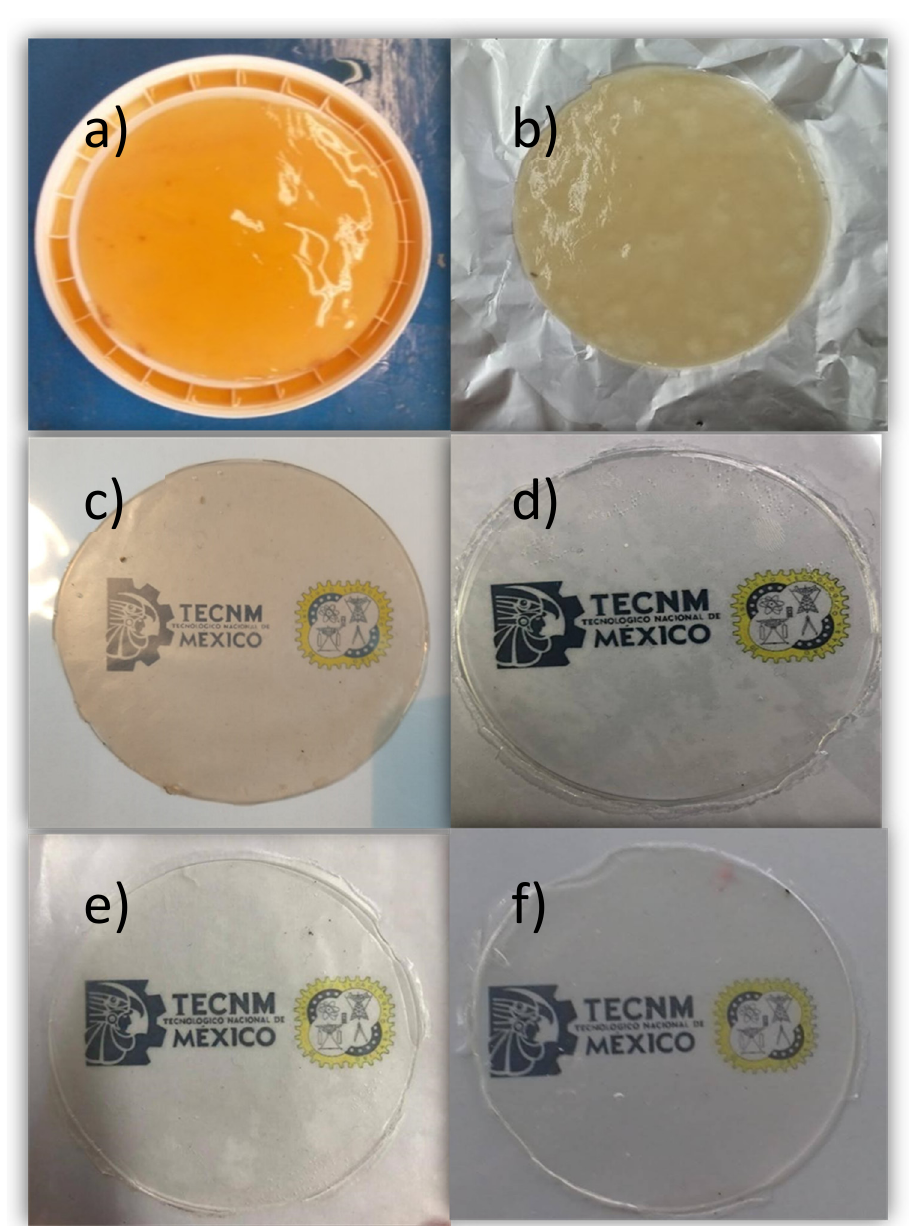
Figure 7. ( a ) Biofilm of kefir PP25 to 35 °C, ( b ) biofilm AP25 to 35 °C, ( c ) edible film of taro, ( d ) edible